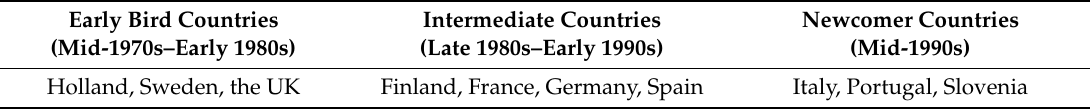
Table 2. Classification based on time of government action against